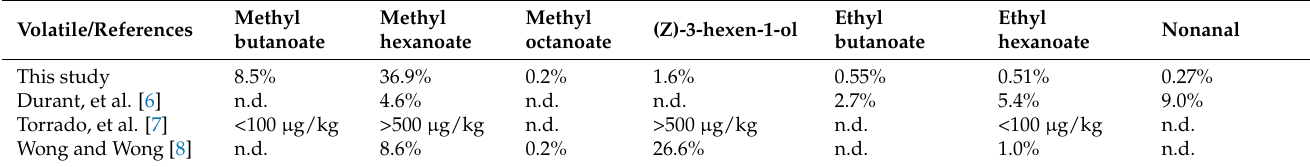
Table 1. Relative percentage of major volatile compounds in tamarillo pulp from this study compared to other